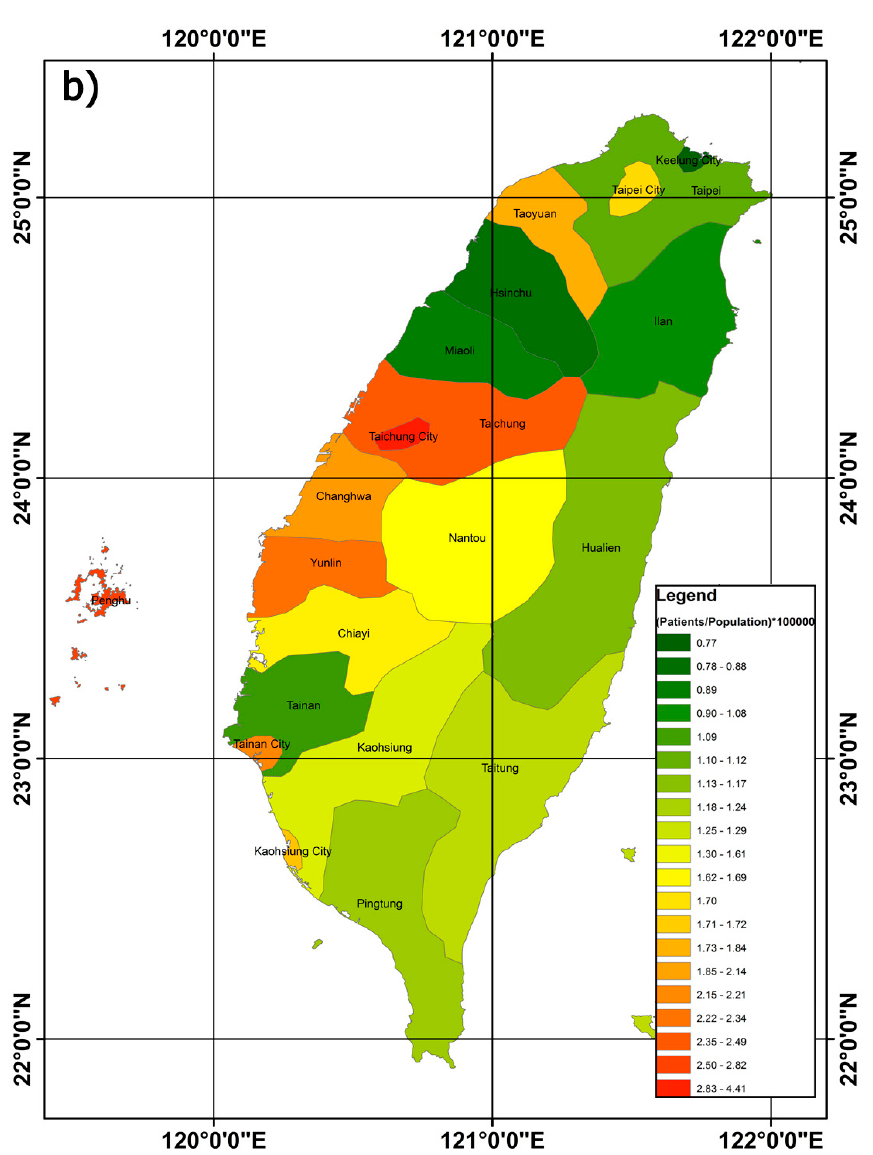
Figure 7. Schematic of satellite-derived PM 2.5 level ( a ) and the ratio of hospital admission for allergic rhinitis to the total population of each individual city in Taiwan ( b ) on 27 March 2008. The PM 2.5 level from ground station measurements are overlaid with color-filled circles in ( a ).